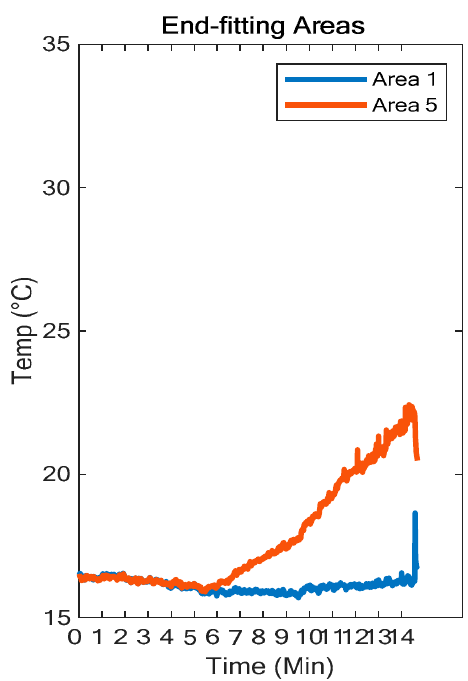
Figure A2. Average temperature of top and lower trunk areas during the whole test (left and right zones). Design CONV, ESDD = 0.42 mg/cm 2 , and a fog rate of 3 L/hr.